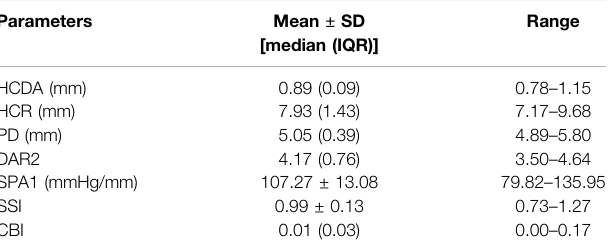
TABLE 2 | DCR parameters from Corvis